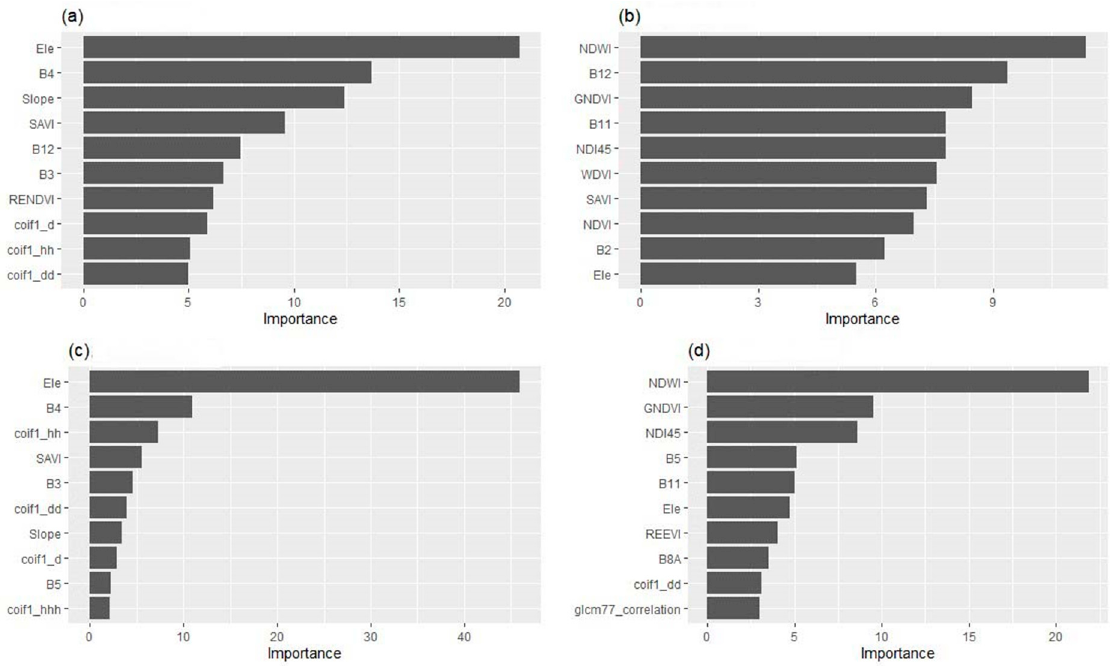
Figure 5. The importance ranking of the top 10 variables identified by ( a ) evergreen RF model; ( b ) deciduous RF model; ( c ) evergreen SGB model; and ( d ) deciduous SGB model .